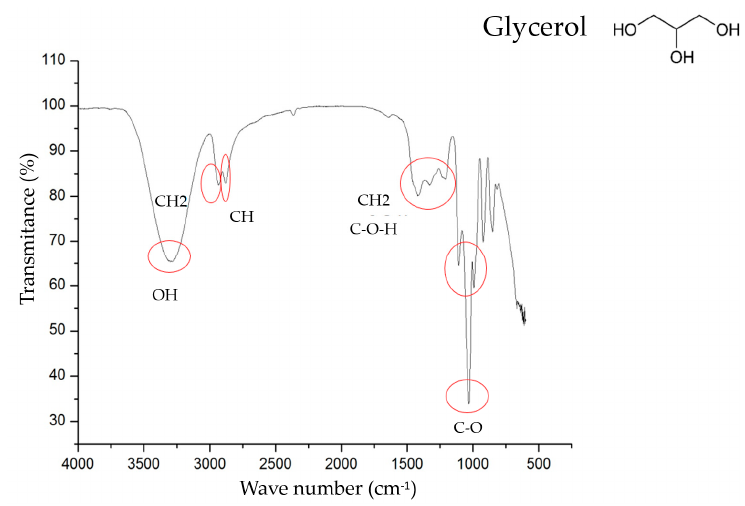
Figure 9. Infrared absorption spectrum of glycerol.